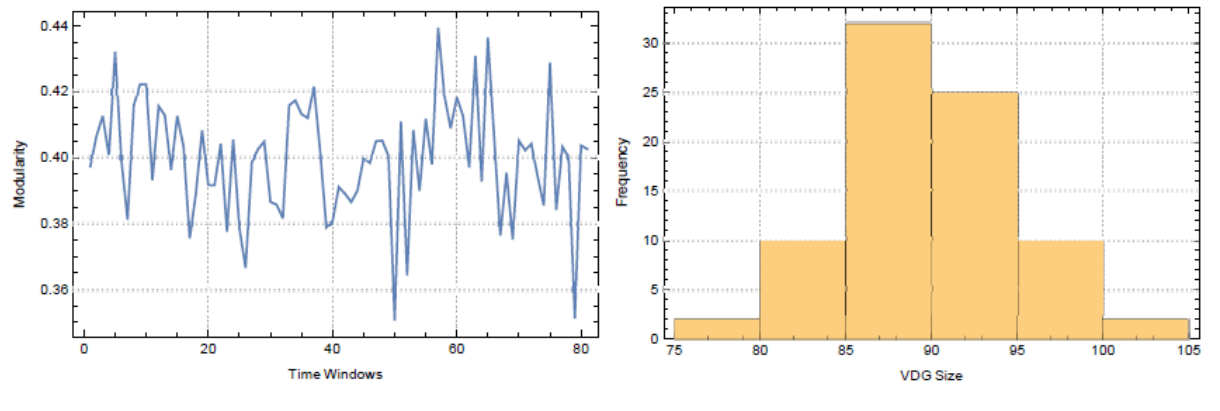
Figure 6. 𝒬 (cid:3037) measures and sizes of coarse graining of 𝐺 (cid:3021)(cid:3037) for BIST. Figure 6. Q j measures and sizes of coarse graining of G j